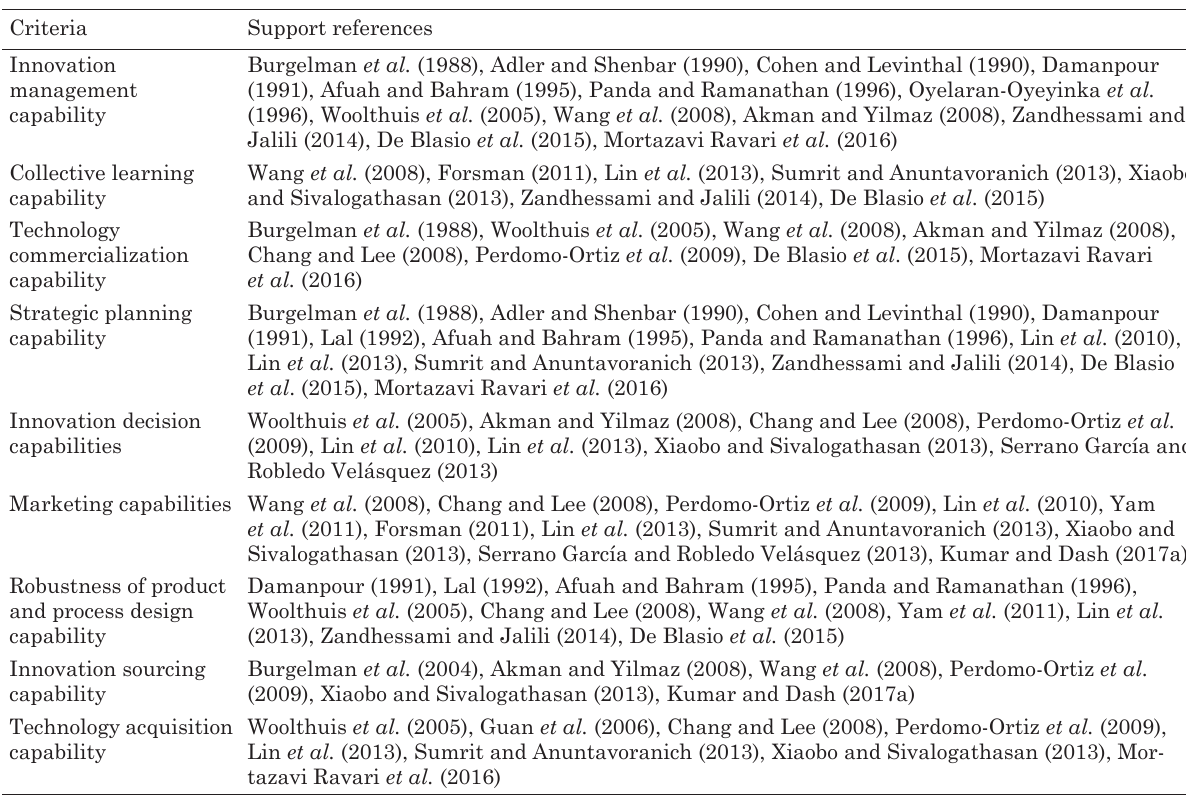
Table 1. Technological innovation capabilities